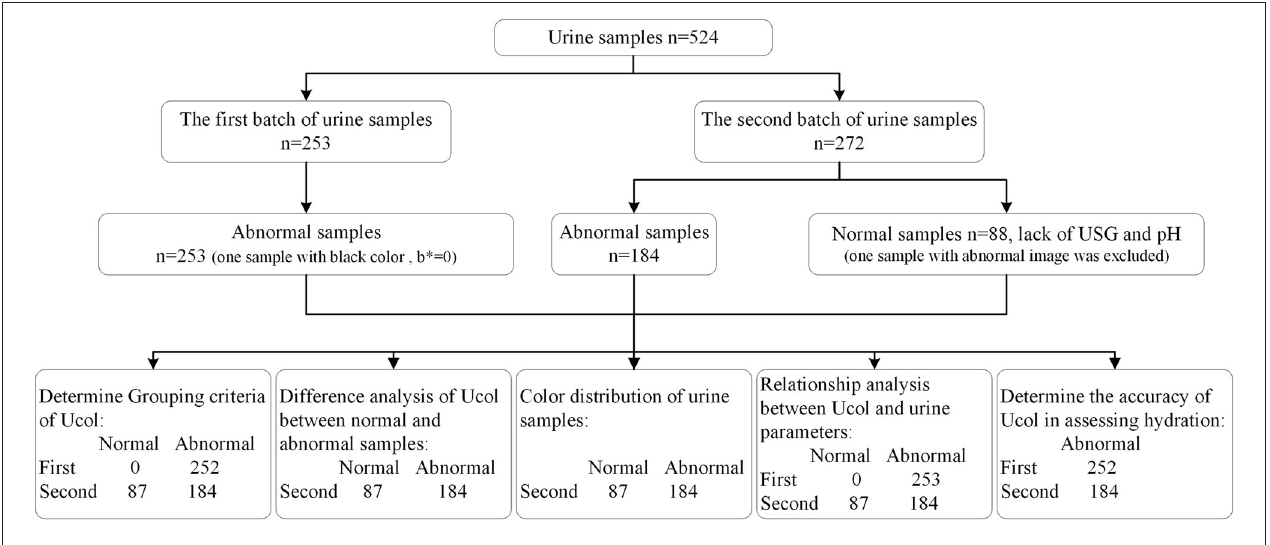
FIGURE 2 | Consort diagram for the study.